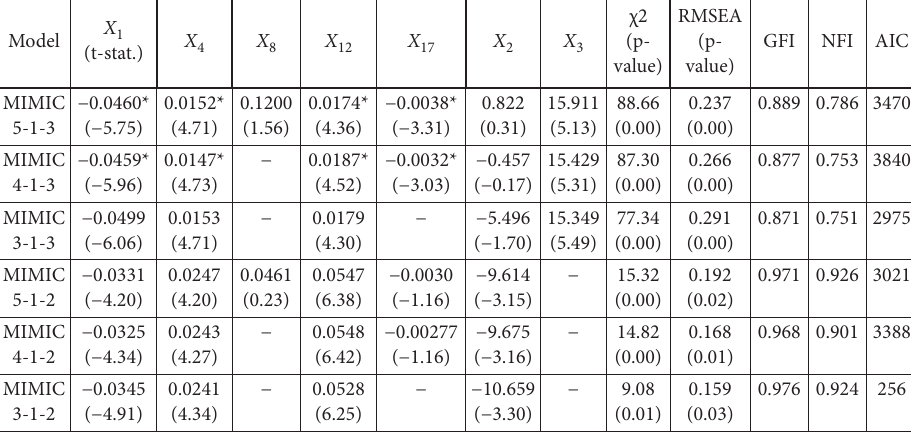
Table 6. Output – LISREL - MIMIC model summary X 1 Model